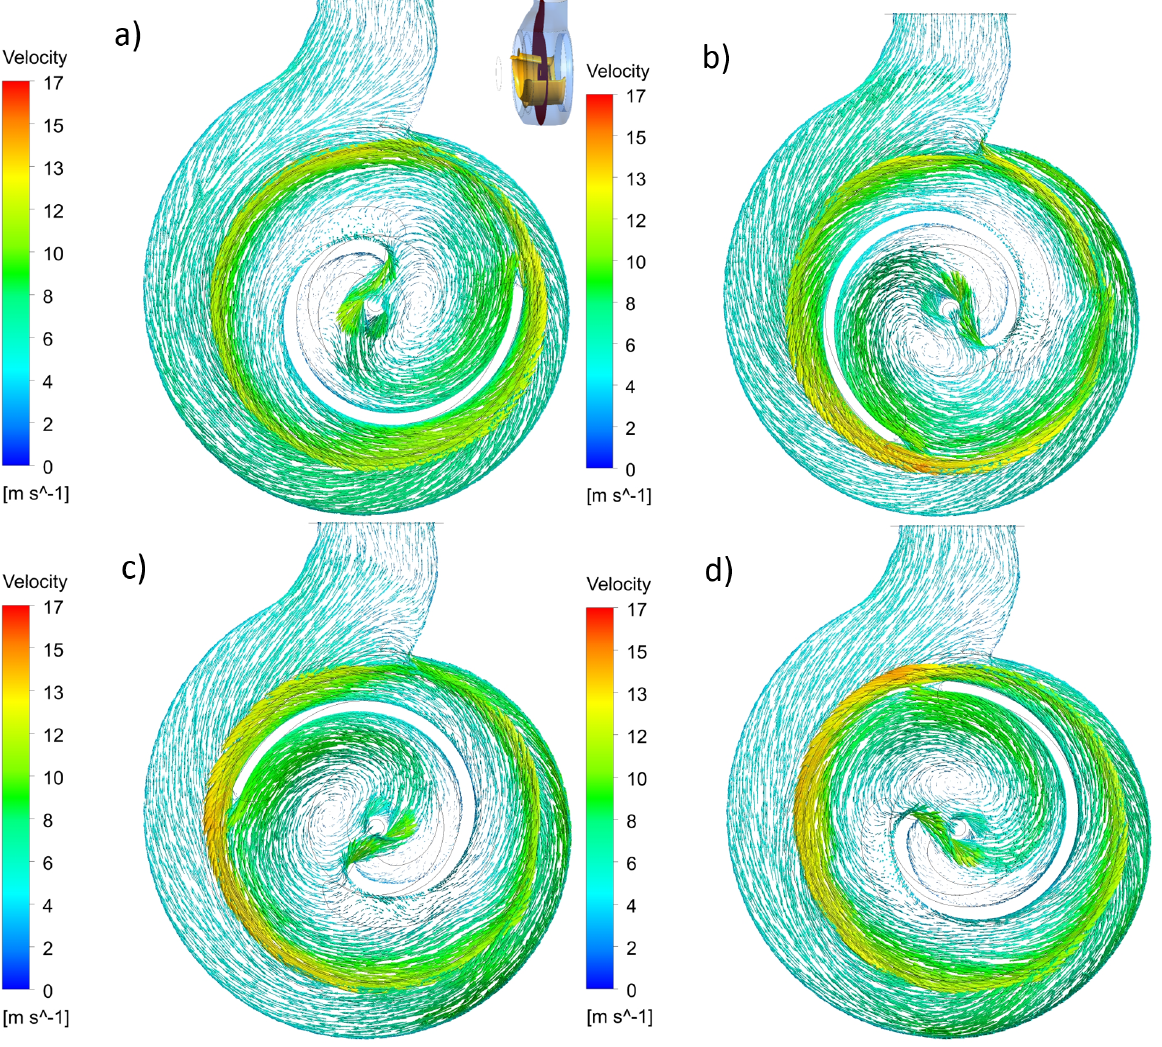
Figure 7: Velocity distribution in the middle cross-section of the pump, the position of the impeller: a) 350 ∘ ; b) 470 ∘ ; c) 550 ∘ ; d) 620 ∘